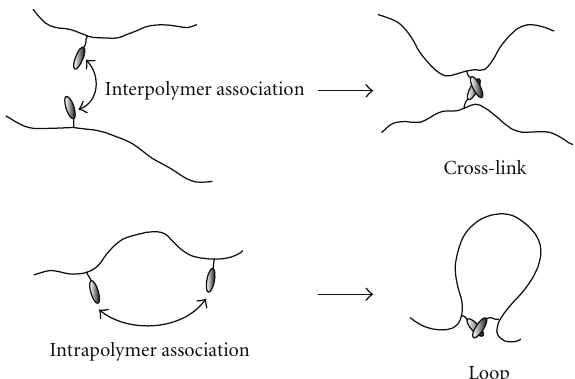
Figure 1: Inter- versus intrapolymer hydrophobe association.